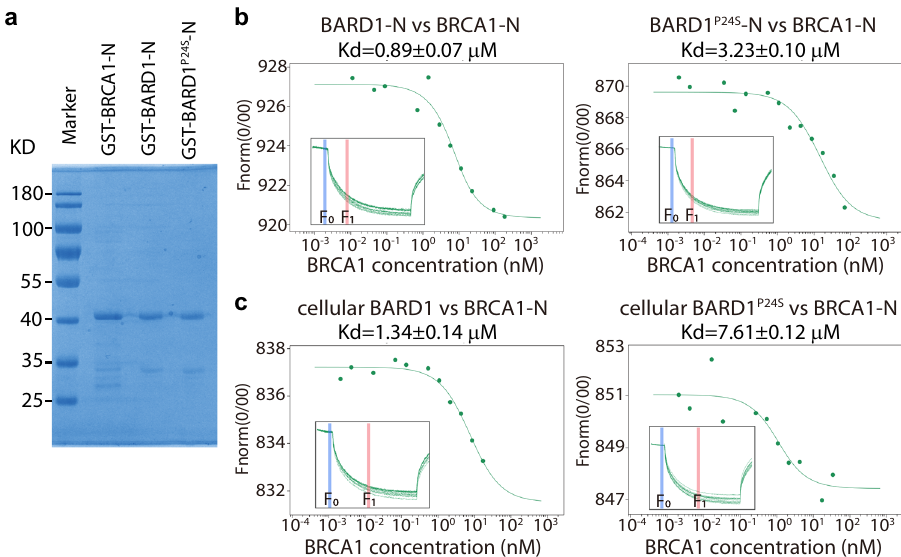
Fig. 3 Binding af fi nity between BARD1 P24S and BRCA1. a Peptide expression and puri fi cation of recombinant N-terminals of BARD1 and BRCA1. The N-terminals of BRCA1 (1 – 147 aa), BARD1 (1 – 142 aa), and BARD1 P24S (1 – 142 aa) were expressed in E. coli with a GST tag followed by af fi nity puri fi cation. b In vitro binding between N-terminals of BARD1 and BRCA1. The binding af fi nity between BRCA1-N and BARD1-N or BARD1 P24S -N was measured by microscale thermophoresis (MST). Inset, thermophoretic movement of fl uorescently labeled proteins. F norm = F 1 / F 0 ( F norm : normalized fl uorescence; F 1 : fl uorescence or fl uorescence after T-jump). Kd , dissociation constant. c Binding between BARD1 from cell fl uorescence after thermodiffusion; F 0 : initial lysates and recombinant BRCA1-N. U2OS cells expressing GFP-BARD1 WT or GFP-BARD1 P24S were lysed. The af fi nity between the fl uorescent BARD1 and recombinant BRCA1-N was measured by MST. Inset, thermophoretic movement of fl uorescent GFP-BARD1 WT or GFP-BARD1 P24S